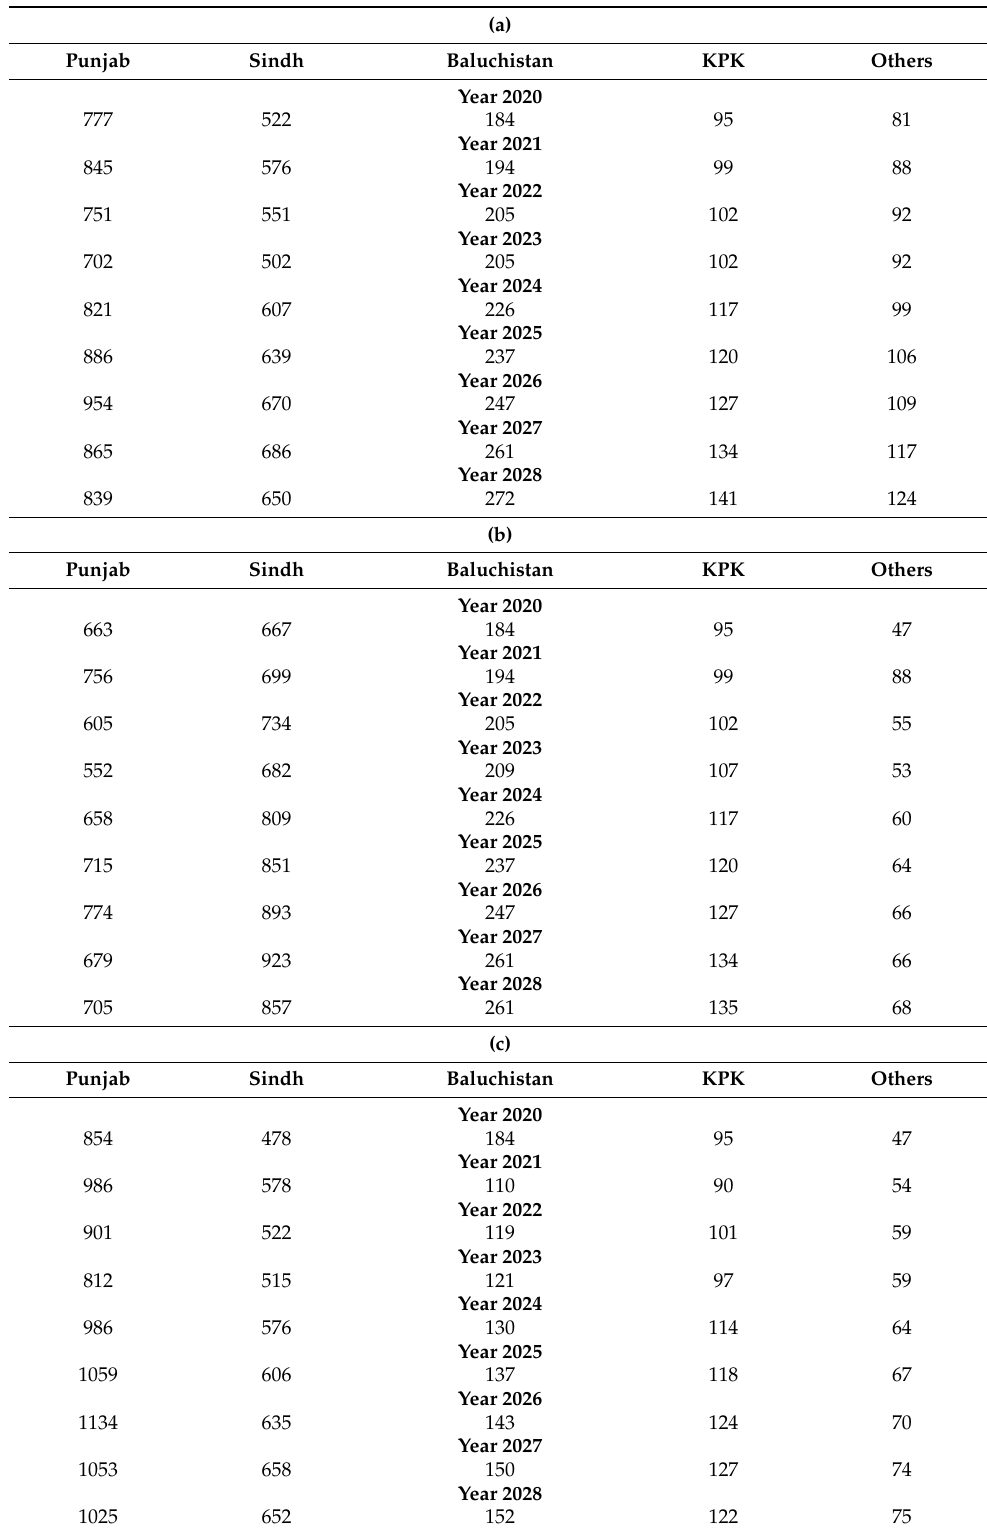
Table 5. ( a ) Gas allocation in BCM using equal weights for years 2020–2028. ( b ) Gas allocation in BCM using bargaining weights (Gas Production) for years 2020–2028. ( c ) Gas allocation in BCM using bargaining weights (Number of gas consumers) for years